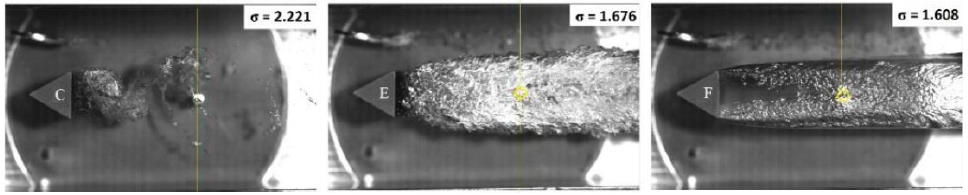
Figure 7. 3D view, σ = 1.676. ( a ) Distribution of temperature on cylinder surface and at test section mid-plane; ( b ) shape of cavities behind cylinder.